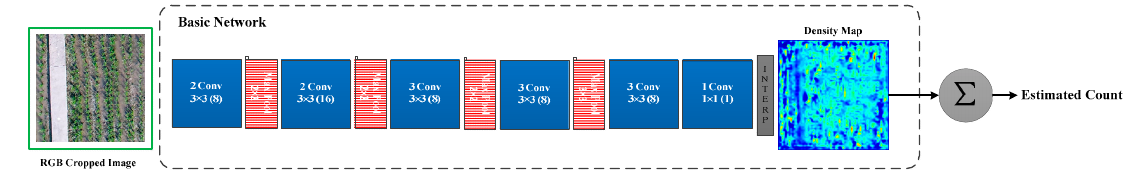
Figure 2. The proposed Basic Network method for counting rice seedlings.